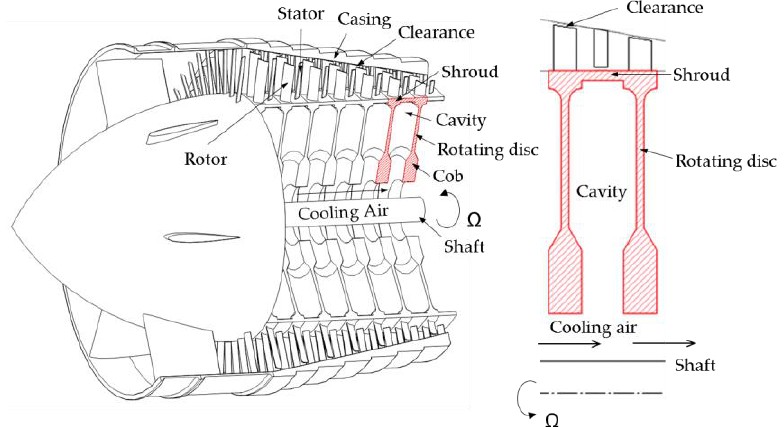
Figure 1. High-pressure aeroengine compressor and schematic diagram of open rotating cavity.